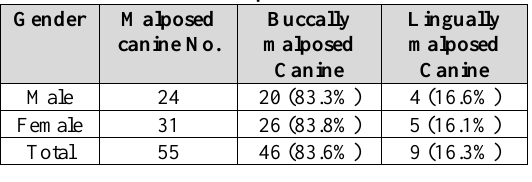
Table 2: Distribution of canine malposition according